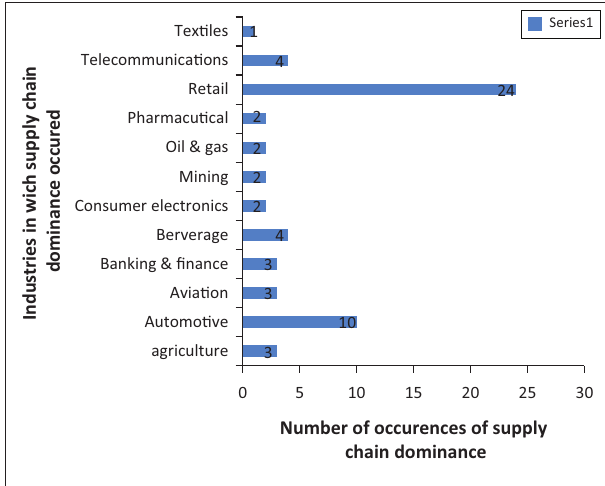
FIGURE 2: Industry specific occurrences of supply chain dominance.